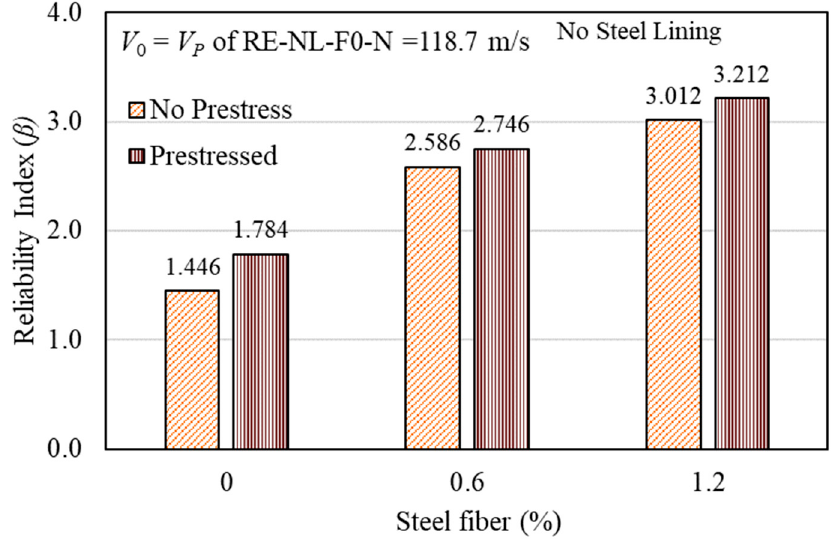
Figure 6. Effect of steel fibers on the reliability of PFRC specimens.